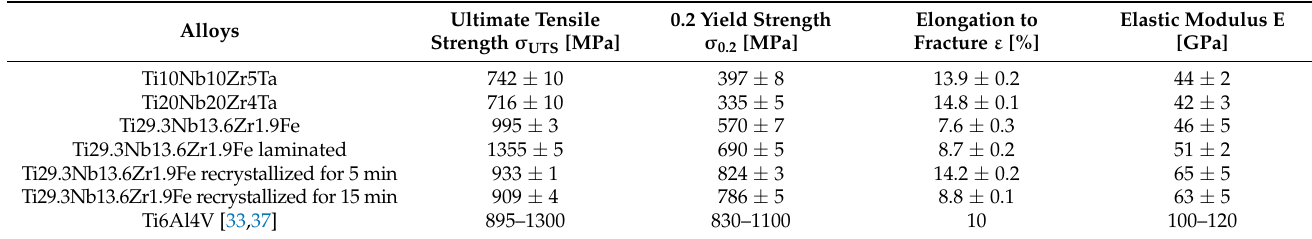
Table 2. Some mechanical properties of the